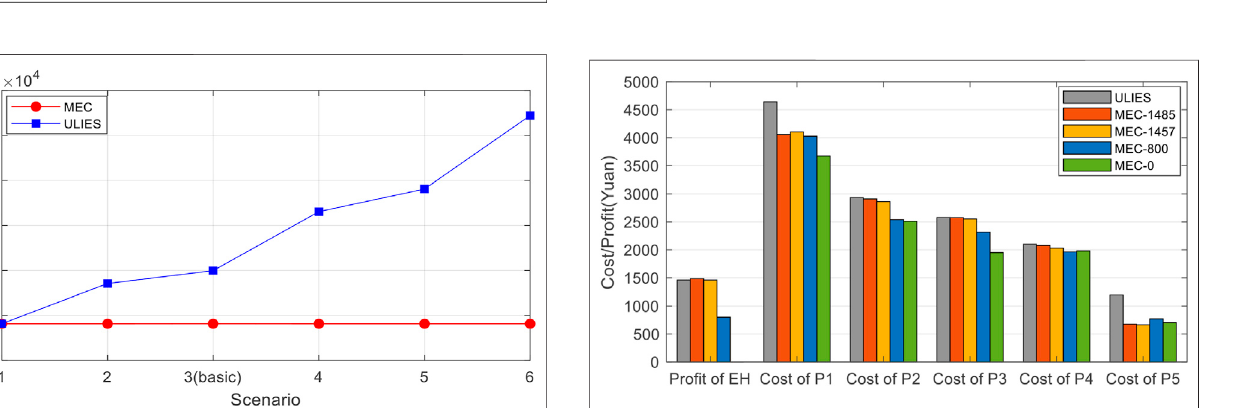
FIGURE 7 | Heat demand composition.